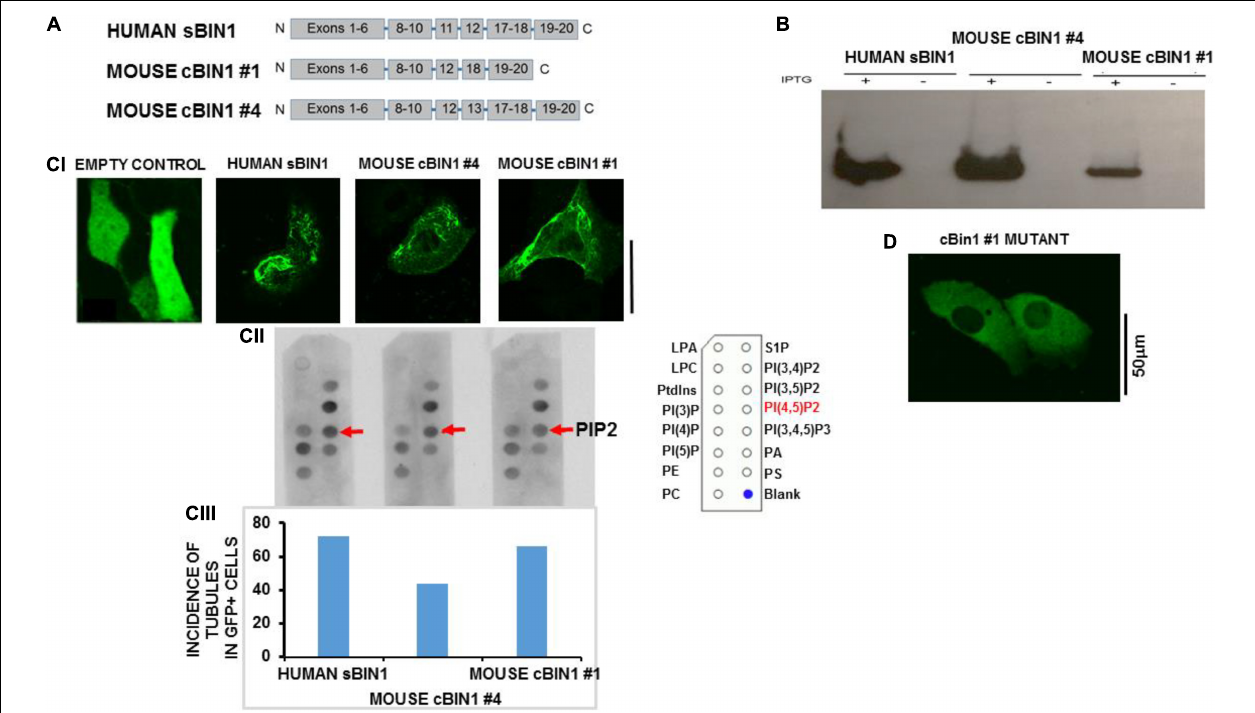
FIGURE 3 | In vitro model of HL1 cells shows tubules after BIN1 overexpression. (A) Gene organization for two splice variants of mouse cardiac muscle BIN1 as well as human skeletal muscle BIN1. (B) The expression of BIN1 proteins induced by isopropyl-b-D-thiogalactoside (IPTG) in bacteria. (C) The interaction between purified Bin1 and PIP2. (CI) Tubule formation in Hl-1 cells 48 h after overexpression with each of the Bin1 constructs. The inset shows that no tubules formed in the overexpression of empty vector. (CII) PIP Strip assays were performed using BIN1 antibody. Representative results from 3 separate experiment are shown and all PIP strip results were confirmed in 1–2 additional strips for each protein. The template describing location of dots for all phospholipids is shown in Supplementary Figure 3 . (CIII) Incidence of tubule formation induced by over expressed BIN1 in HL1 cells for each construct. No tubules were formed in cells with empty vector. ( N = 48 cells/3 cultures for each including empty vector). (D) Example of an HL-1 cell over-expressing a construct with triple mutations of Lys164Glu/Lys165Glu/Lys166Glu in a loop segment of the N-BAR coiled-coil domain completely abolished tubule formation. No tubulation was found in any GFP-positive cells ( N = 36 cells/3 cultures). Note that the vector contains a GFP tag so Bin1 can be easily visualized. Pixel size was 0.11 µ m/pixel and all images were obtained with the pinhole adjusted to Airey units =